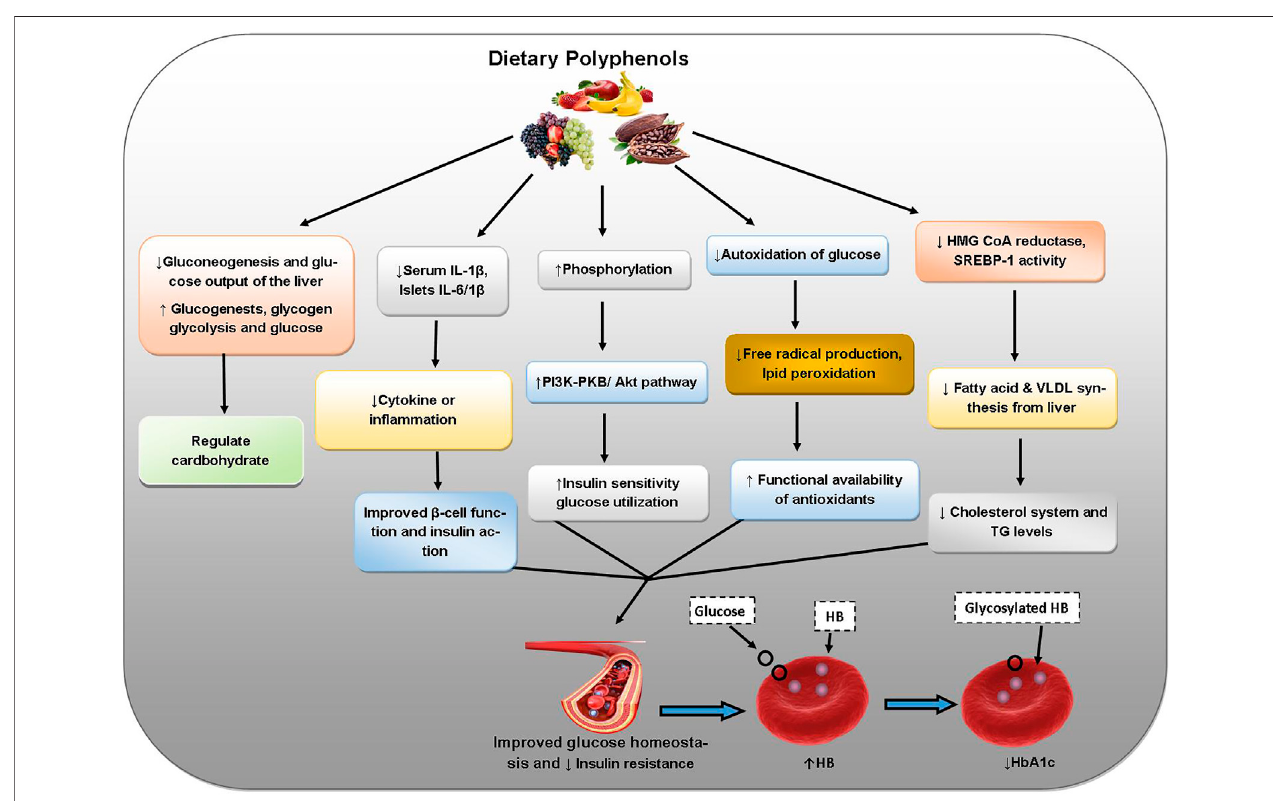
FIGURE7 | Protective rolesofdietary polyphenolsagainst diabetes. Abbreviations: IL-1 beta: interleukin-1 β , IL-6/1B: interleukin-6, P13K-PKB: phosphoinositide- 3-kinase – protein kinase B, Akt: AK strain transforming, HMG CoA reductase: β -hydroxy- β -methylglutaryl-CoA reductase, SREBP-1: sterol regulatory element-binding protein 1, VLDL: very low density lipoproteins, TG: Triglycerides, HB: